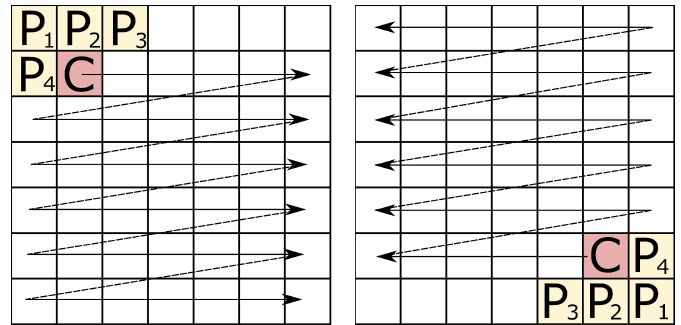
Figure 1. The L-shaped mask used in the original Modified Transformation and its sliding manner the double-scan